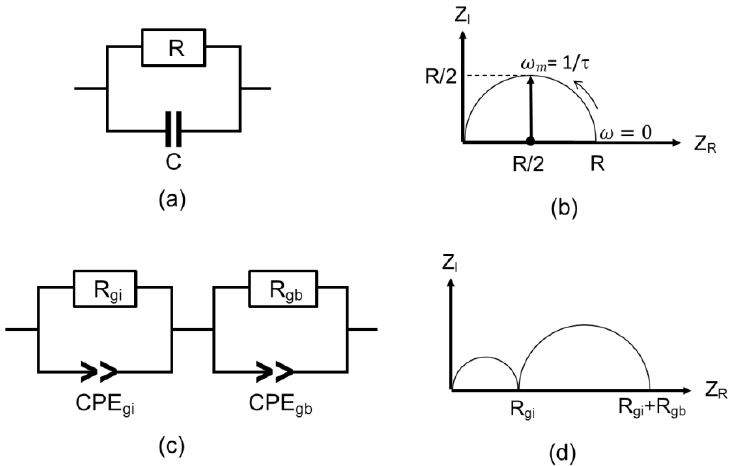
Figure 2. Equivalent circuits for ( a ) single crystal and ( c ) polycrystal samples, and their corresponding Nyquist plots ( b , d ), respectively. Impedance Z( ω ) = Z R ( ω ) − Z I ( ω ) j, where Z I ( ω ): negative of R: bulk resistance, CPE: constant phase element, subscript gi: grain interior contribution, and subscript gb: grain boundary contribution.